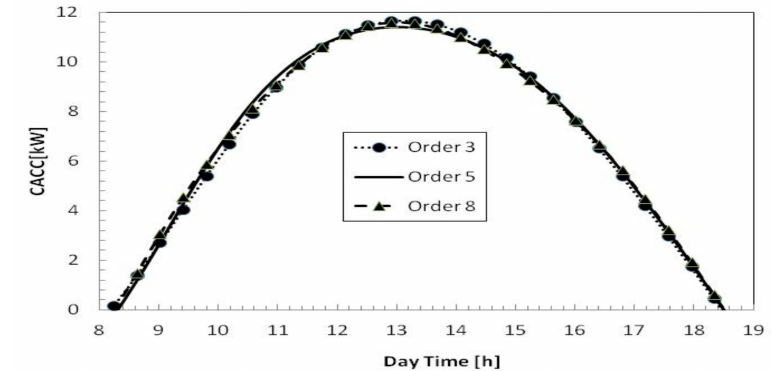
Figure 7. Cyclic average cooling capacity with a di ff erent order of Fourier series for Perth